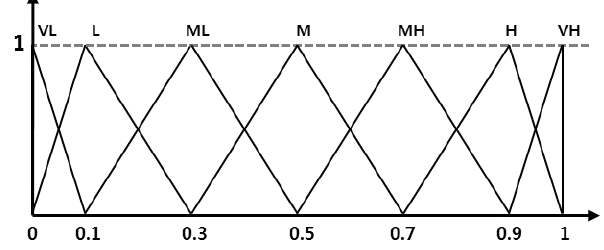
Fig. 4. Fuzzy linguistic terms for the weight of each criterion. Table 1. Linguistic variables for the importance weight of each cri-